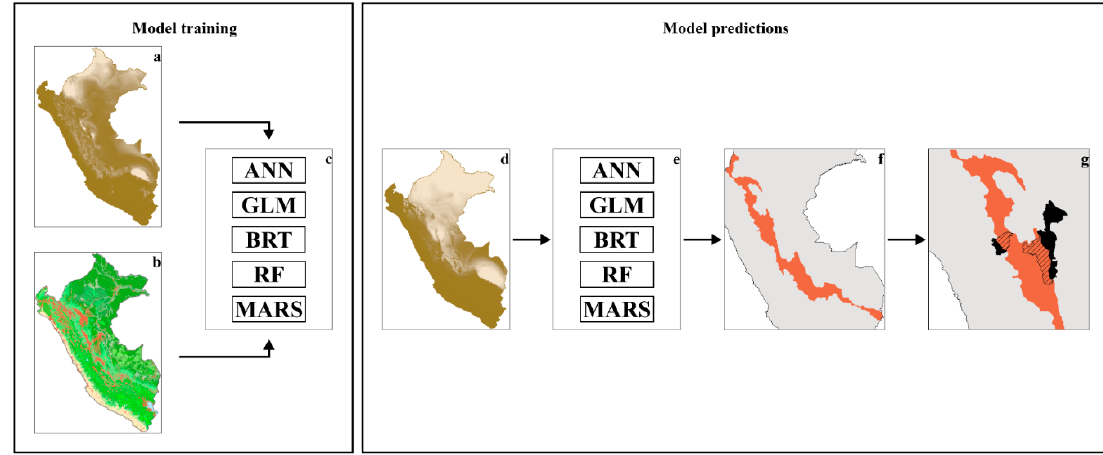
Figure 2. Flow diagram of the methodology employed to examine potential impacts of climate change on montane forests and protected areas. Left : Model training. Training data is extracted from current climate ( a ) and land cover datasets ( b ) to fit an ensemble of five classification models ( c ). Right : Model predictions. Future climate datasets derived from 17 GCMs ( d ) are used as input for the fitted classification models ( e ) to generate a consensus forecast of high potential climate change impact on montane forests in 2070 (indicated by the red area; ( f ). Impacts on montane forests in protected areas (indicated by black polygons; ( g ) are estimated by calculating the extent of high climate change impact within their current distribution (indicated by the shaded areas; ( g ).